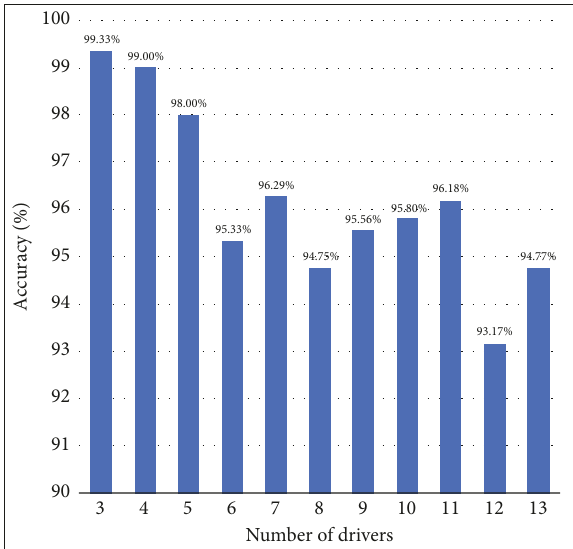
Figure 14: Plot of the accuracy across set of drivers.